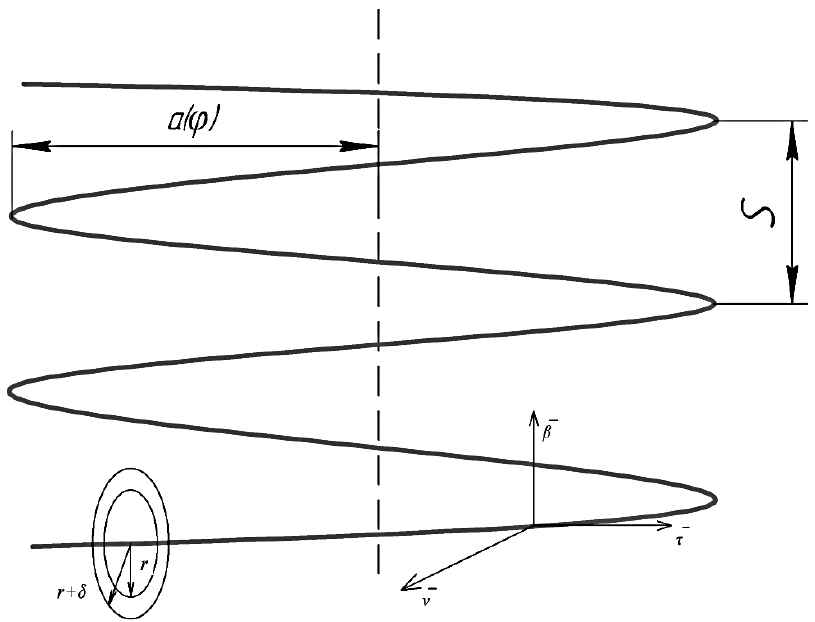
Figure 2. Coordinate system: S —step, a ( ϕ ) —curving radius, r —radius of the pipe, δ —thickness of the pipe.